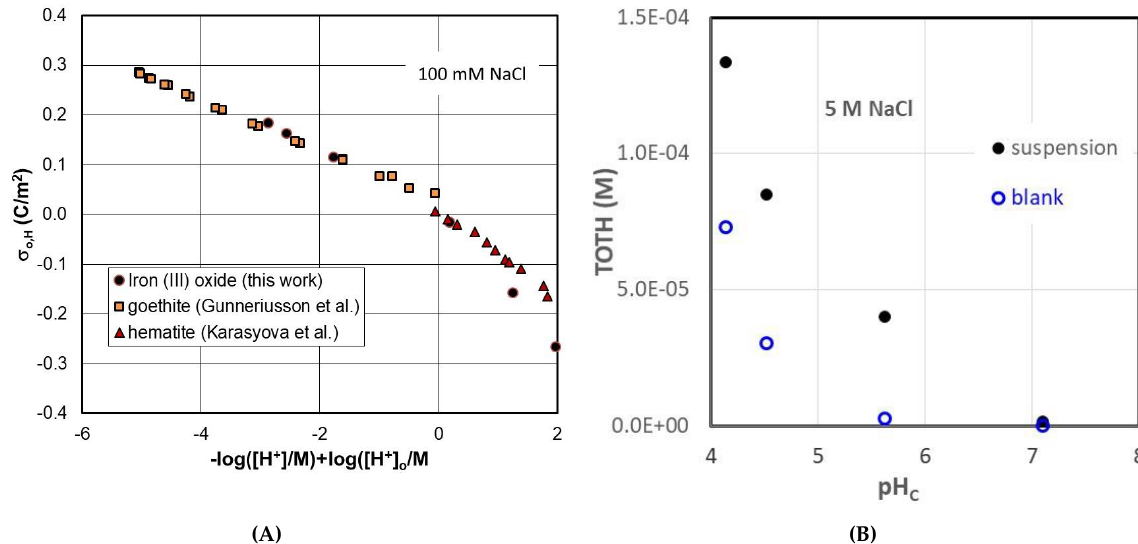
Figure 4. (A) Proton related surface charge density ( σ o,H ) as a function of the difference of − log ([H + ]/M) and − log ([H + ] o /M) in comparison to data reported for goethite by Gunneriussion et al. [53] and hematite by Karasyova et al. [54]. (B) Comparison of blank and suspension titration for 5 M NaCl salt concentration and 1.39 g/L synthetic Fe(III)